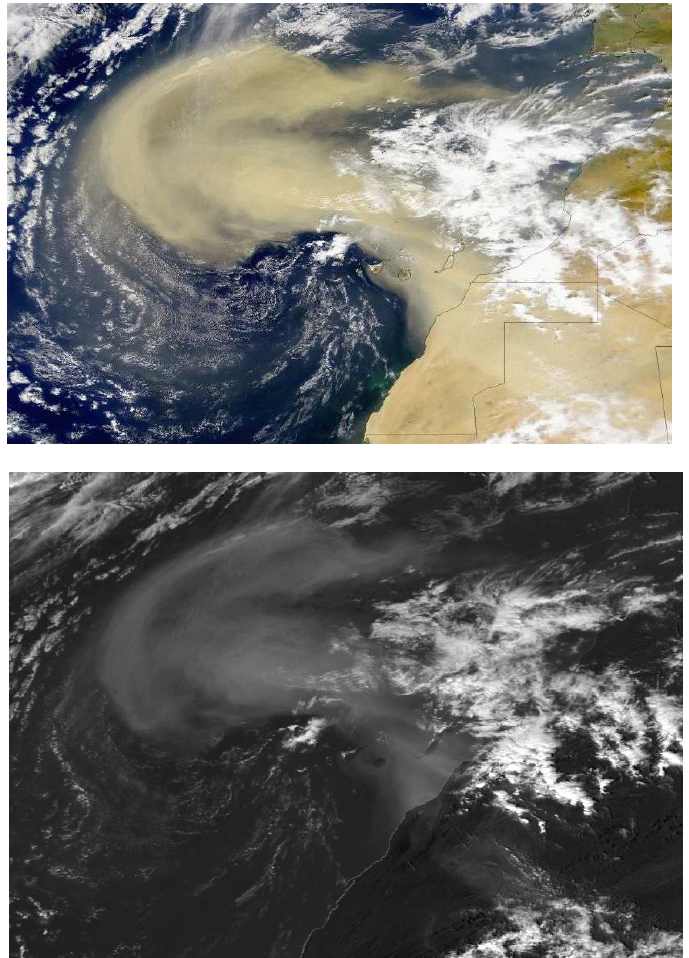
Figure 2. Example of the effect of aerosol events on CAL. The SesWIFS image from 26 February 2000 [18,21] shows clearly a dust storm over parts of the land and ocean (top, yellowish color). The “dust cloud” shows a different texture than the surrounding water clouds. This dust cloud leads to a significantly increased CAL value (bottom), which subsequently leads to significantly lower solar surface radiation, see Figure 4. The top figure has been provided by SeaWIFS project, NASA/GSFC and